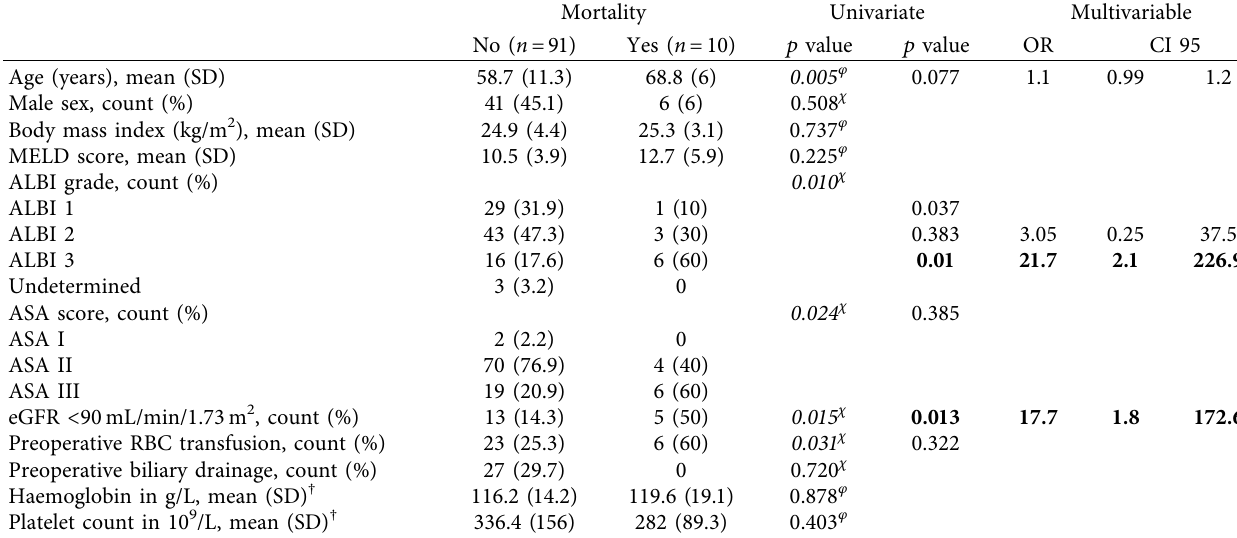
Table 3: Univariate and multivariable analysis for prediction of 90-day mortality after pancreaticoduodenectomy for ampullary